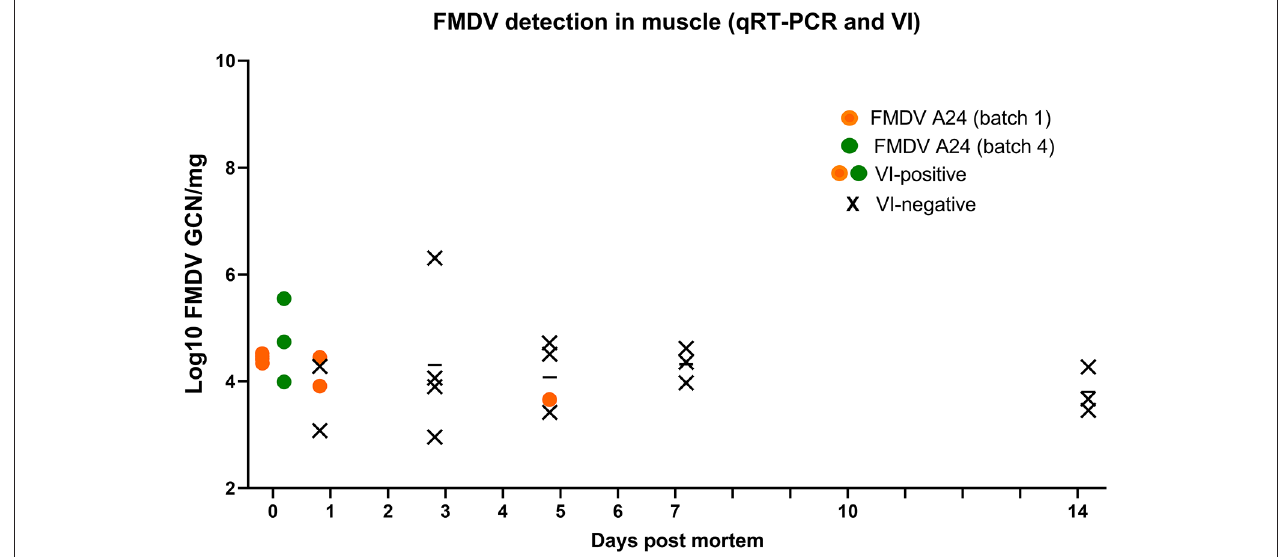
FIGURE 3 | FMDV detection in the semitendinosus muscle of pig carcasses. FMDV RNA quantities (log 10 GCN/mg) in muscle samples from FMDV-infected pigs obtained from 0 to 14 days post mortem (dpm) from carcasses stored at 4 o C. Colored symbols indicate samples from which infectious virus was isolated, while X indicate virus isolation-negative samples. Carcasses from batch 1 ( n = 4) were samples at 0, 1, 3, and 5 dpm and carcasses from batch 2 ( n = 3) were sampled at 0, 7, and 14 dpm. All symbols represent individual sample replicates ( n = 7), horizontal lines are means.